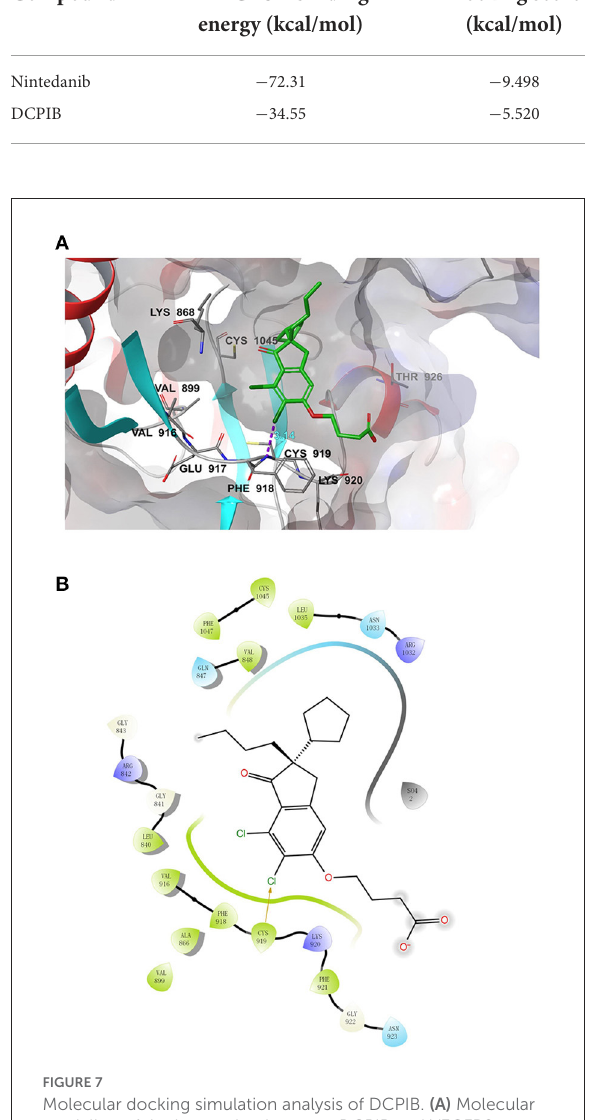
FIGURE7 Molecular docking simulation analysis of DCPIB. (A) Molecular modeling of the interaction between DCPIB and VEGFR2. Docking pose of VEGFR2 with DCPIB was shown in the graph. (B) Docking pose of DCPIB with VEGFR2 using a two-dimensional diagram.